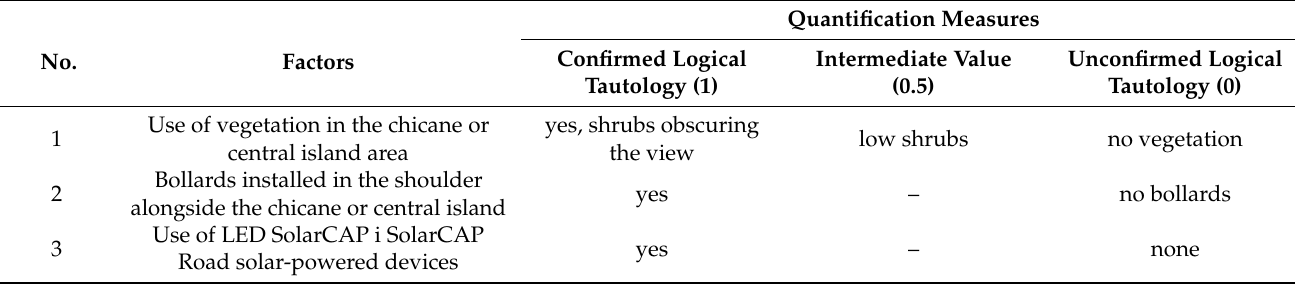
Table 7. Additional factors and the applicable quantification measures.